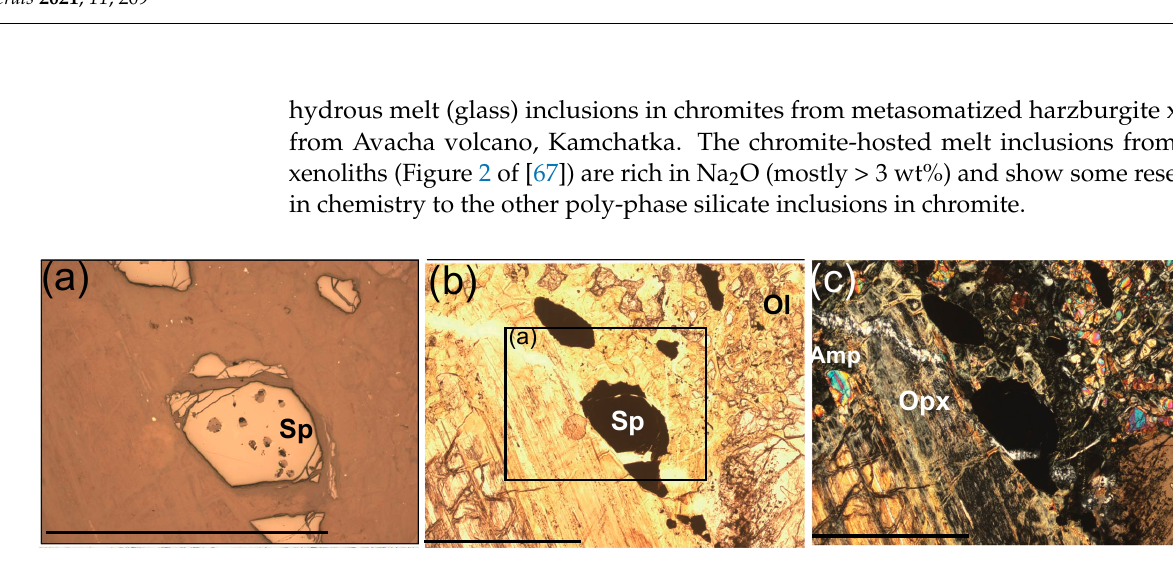
Figure 4. Photomicrographs of chromite-hosted silicate inclusions in a metazomatized harzburgite from the Circum-Izu Massif Serpentine Belt (Setogawa, Shizuoka, Japan). ( a ) Chromite containing globular silicate inclusions. Reflected light. ( b ) Harzburgite. The position of panel ( a ) is shown. Plane-polarized light. ( c ) Crossed polarized light. Sp, chromite; Opx, partially serpentinized orthopyroxene; Ol, serpentinized olivine; Amp, pargasite. Scale bar, 1 mm.